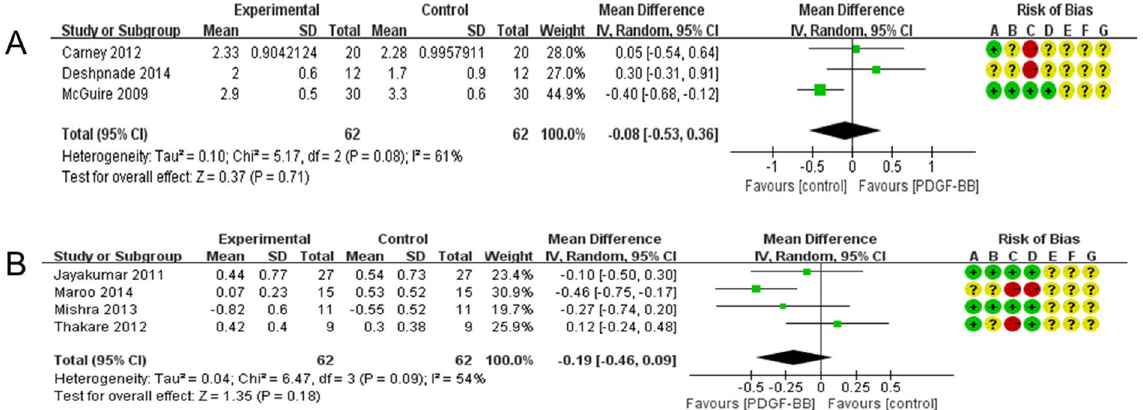
Figure 4. ( A ) Forest plot of comparison: 0.3 mg/ml PDGF-BB groups was compared with control groups among patients with gingival recession, outcome: GR. ( B ) Forest plot of comparison: 0.3 mg/ml PDGF-BB was compared with control groups among patients with osseous defects, outcome: